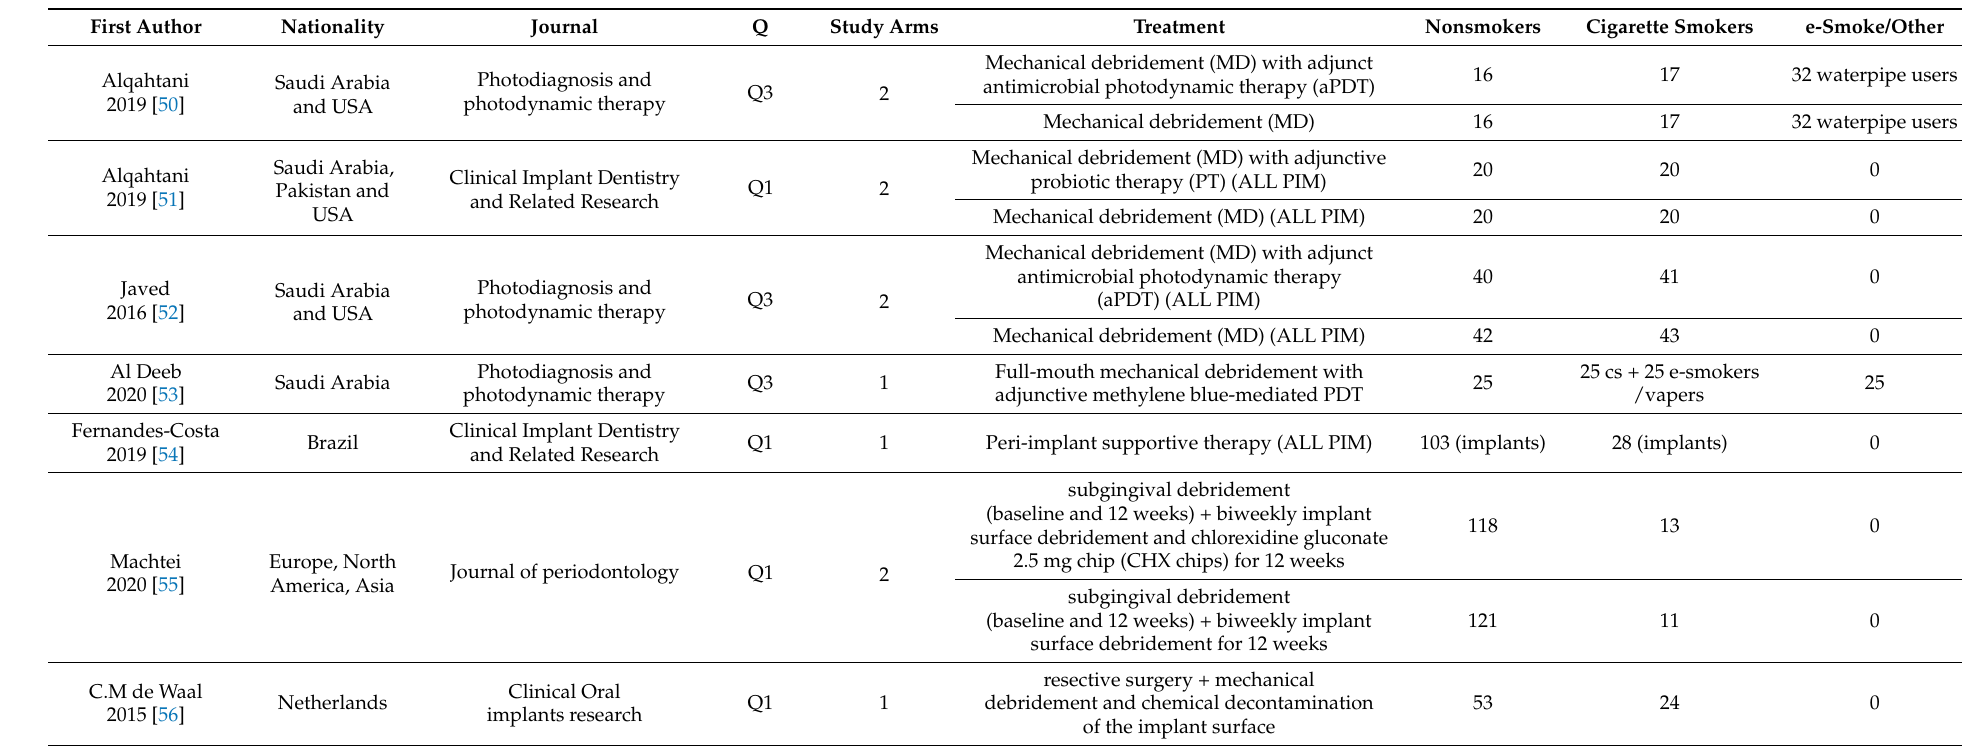
Table 2. Description of included studies. Q = journal impact factor quartile, study arms: number of treatments considered in the